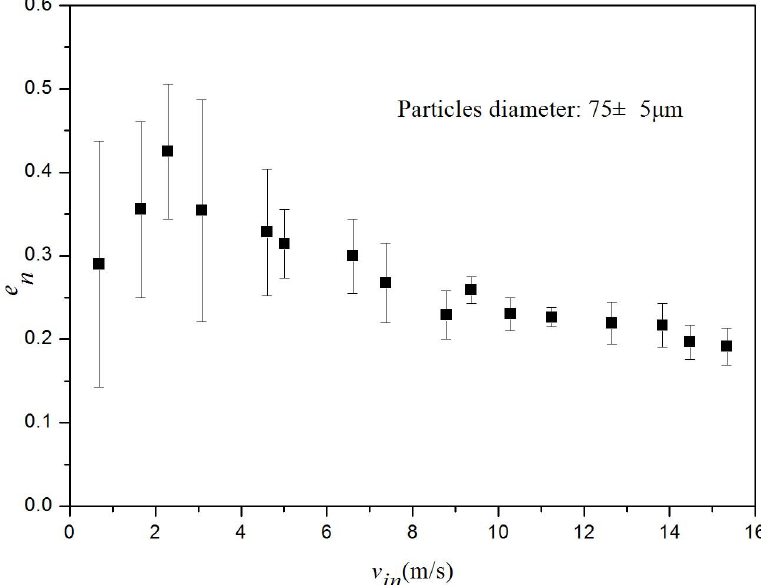
Figure 10. The sample mean values of normal restitution coefficient, e normal velocity component, v , for the normal impact of fly ash particles diameter of 75 ± 5 μ in